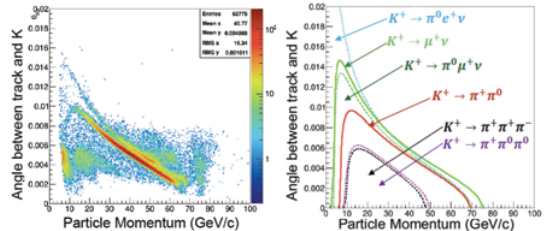
Figure 4. Angle between the reconstructed track and the nominal kaon direction as a function of particle momentum [GeV / c] for data (left) and as expected from pure kinematics (right).